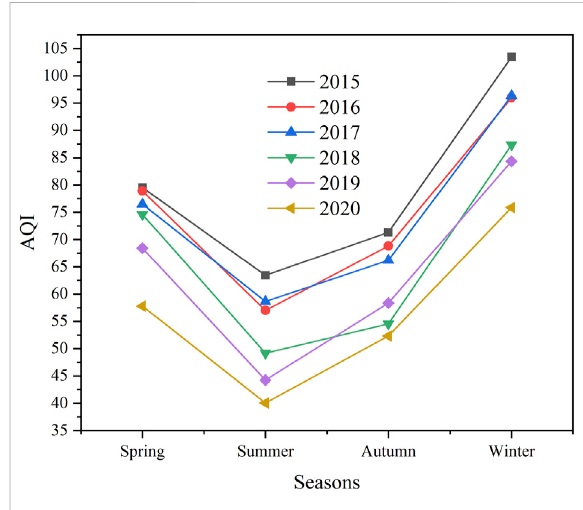
FIGURE 4 Seasonal variations in site averaged air quality index in China.